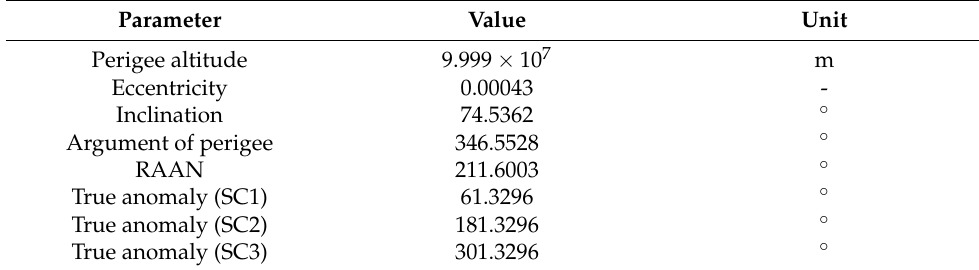
Table 2. Initial